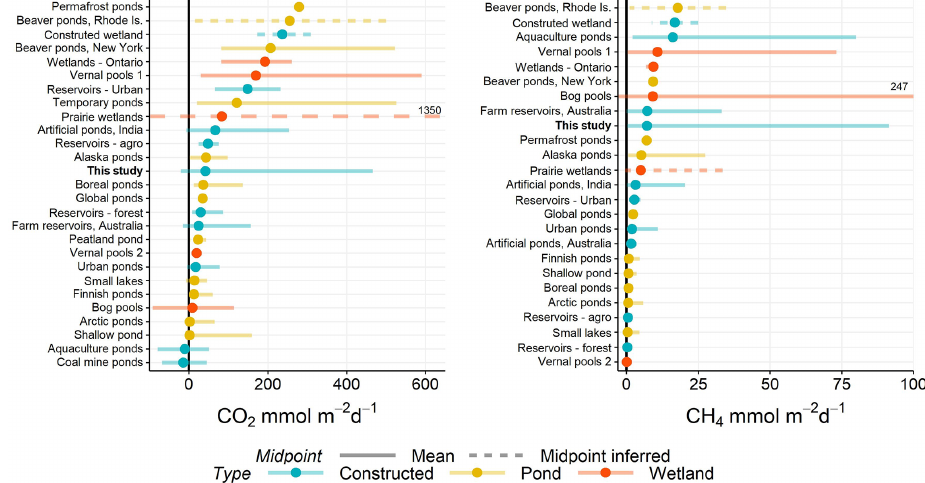
Figure 5. Range of CO 2 and CH 4 (diffusive) fluxes observed in natural and constructed small ( < 0 . 01km 2 ) waterbodies, including this study (farm reservoirs). Dots represent the mean reported in each study and error bars the range. If no mean value was reported, then the midpoint was inferred as the middle of range (dashed lines). Solid black line distinguished between positive and negative fluxes. All data are from the published literature and references can be found in the Table S6.